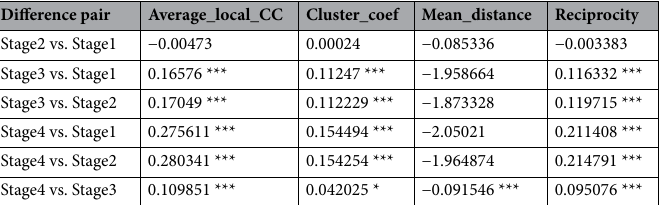
Table 3. Descriptive statistics of the communication networks of each forum. “Stage A vs. Stage B” indicates the value of Stage A minus the value of Stage B; ***p < 0.001, **p < 0.01, *p < 0.05.